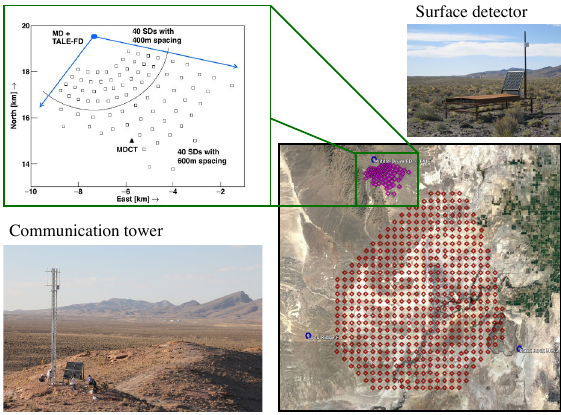
Figure 1. The detector configuration of TA SD and TALE SD. The square grid is used in the TA SD deployment, while the hy- brid detection e ffi ciency is maximized for the arrangement of TALE SD. The picture of communication tower and individual surface detector are